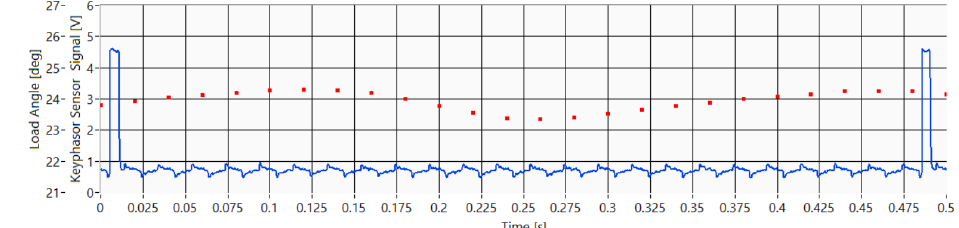
Figure 15. Results of the load angle measurement when the load angle correction function is applied. The red dots represent the corrected load angle values.